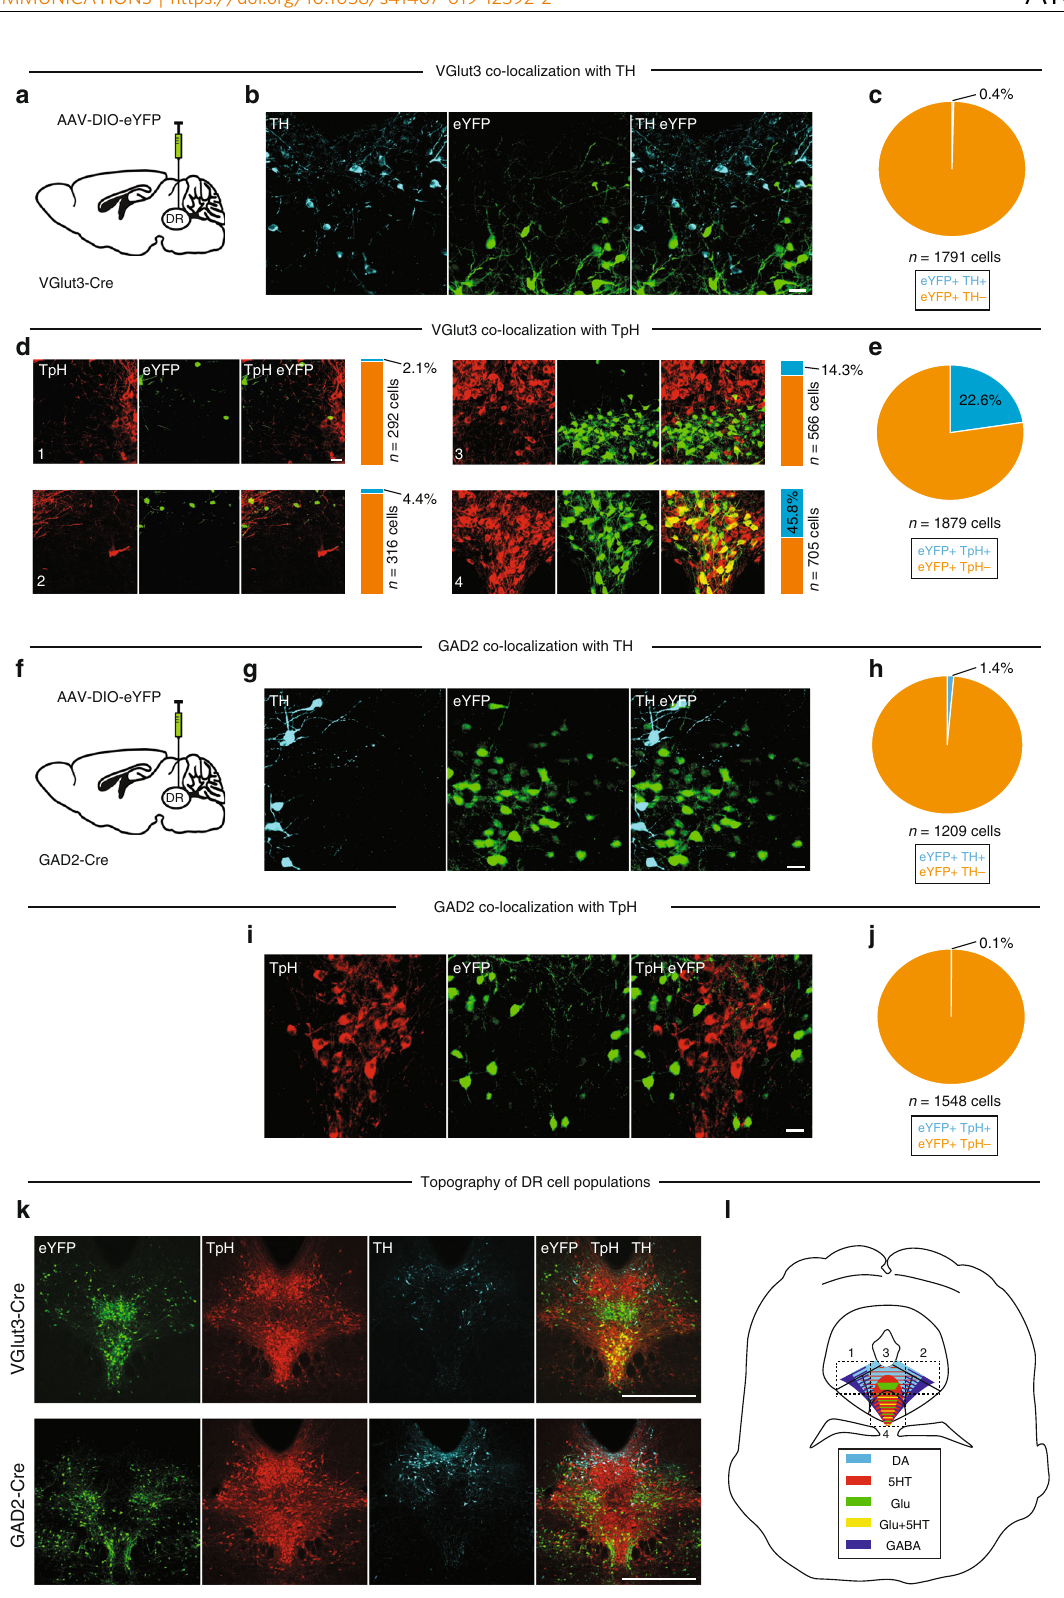
the lateral DR, DA (DAT-positive) neurons are found mostly in proximity to the aqueduct, and glutamatergic (VGlut3-positive) neurons are concentrated in the medial DR and subdivided into dorsal and ventral groups with minimal and signi fi cant co-